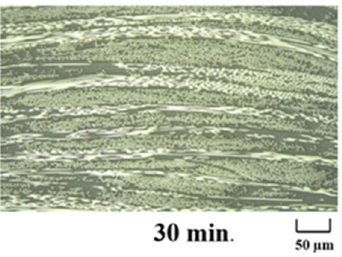
Figure 13. Cross-sectional photographs of composite materials made at different molding times un- der molding pressure is 5 MPa.